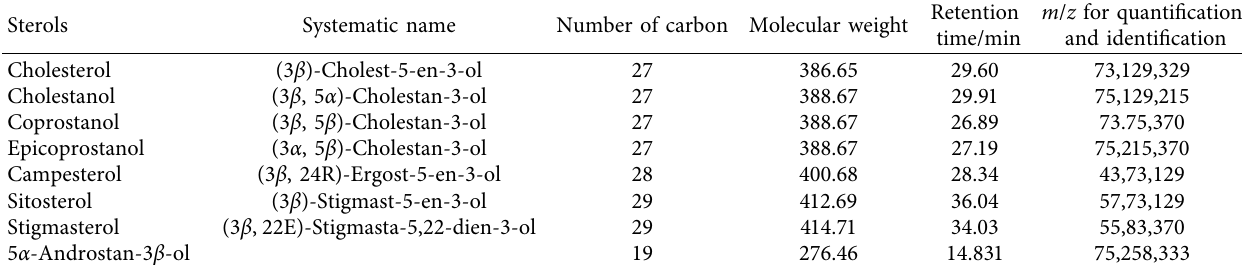
Table 2: Peak time and characteristic ions of sterols for GC-MS.